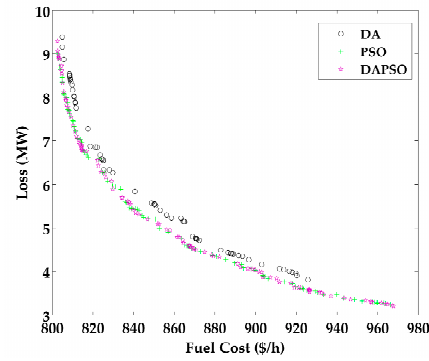
Figure 3. Two-dimensional Pareto fronts when considering fuel cost and transmission losses as part of the objective function for the IEEE 30-bus system.